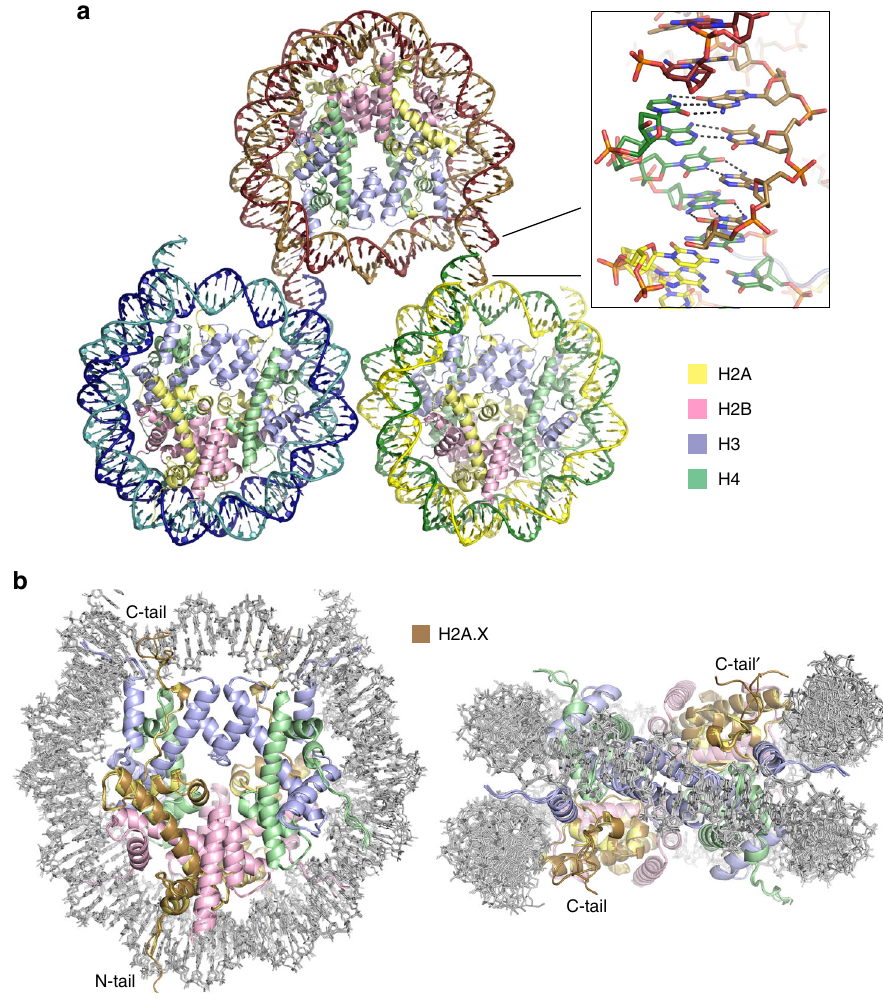
Fig. 2 Structures of NCP composed of H2A and the H2A.X variant. a Inter-nucleosomal annealing of the 4-nucleotide 3 ′ overhangs in the 147s-NCP structures (NCP assembled with H2A shown) yields continuous, 147 bp repeat, fi bres composing the lattice. b Five NCP structures corresponding to superposition of the H2A.X-NCP, γ H2A.X-NCP, H2A.X-S139E-NCP and H2A-147s-NCP models onto that of H2A-(145bp)-NCP. a , b Histone proteins are coloured by type: H2A, yellow; H2A.X, bronze; H2B, pink; H3, purple; H4,